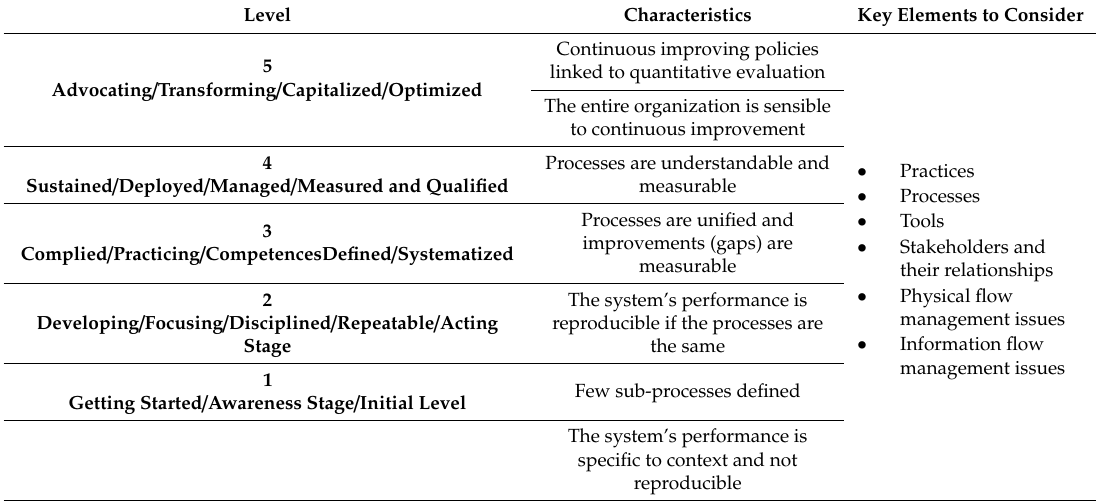
Table 1. Maturity model levels and common characteristics among the di ff erent research fields (authors’ elaboration from synthesis of references cited